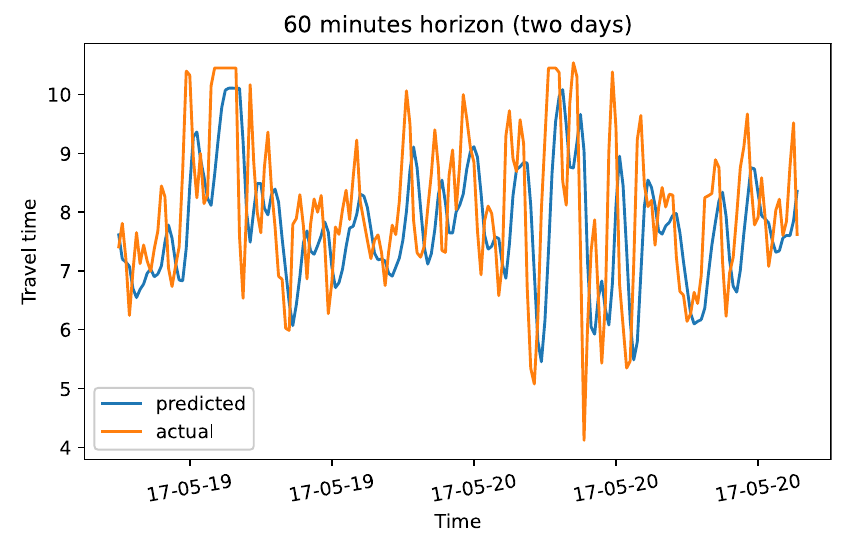
Fig 13. Prediction results for 60 minutes horizon on test data (two days).